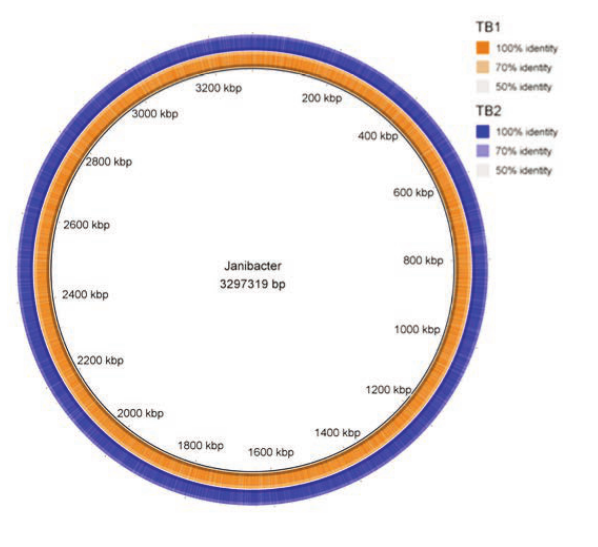
Figure 1. Venn diagram comparison of gene composition between strains TB1 and TB2 cultured from valve tissues of a patient with aortic stenosis, and Janibacter terrae.